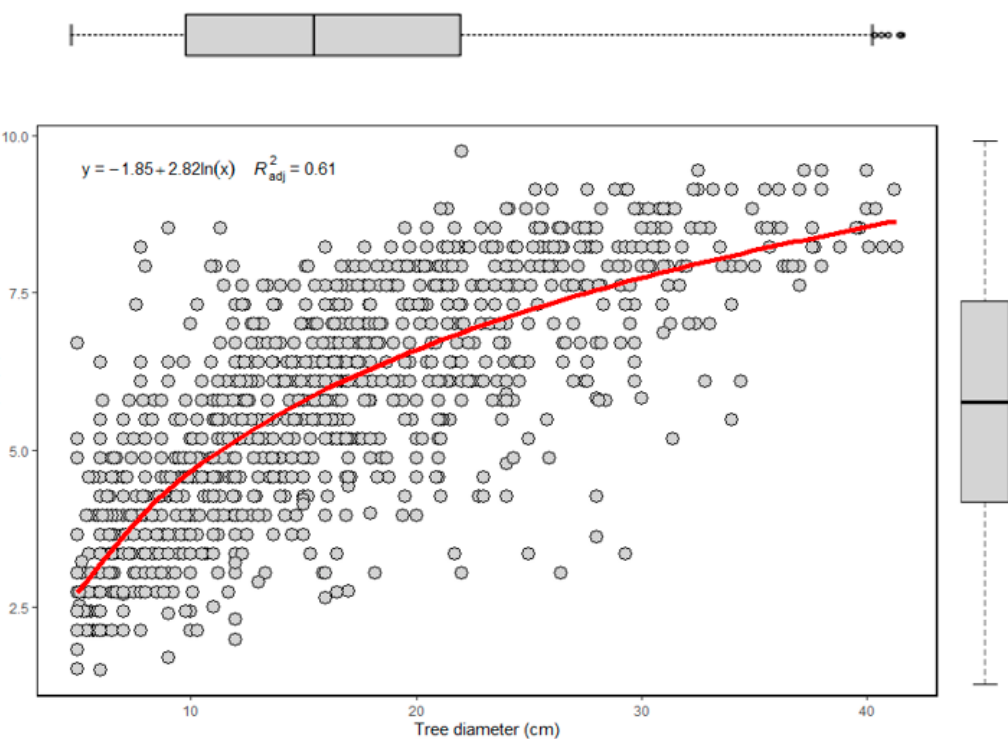
Figure 4. Scatter plot of tree height vs diameter in the mangrove stand of LetKhutKon Village.